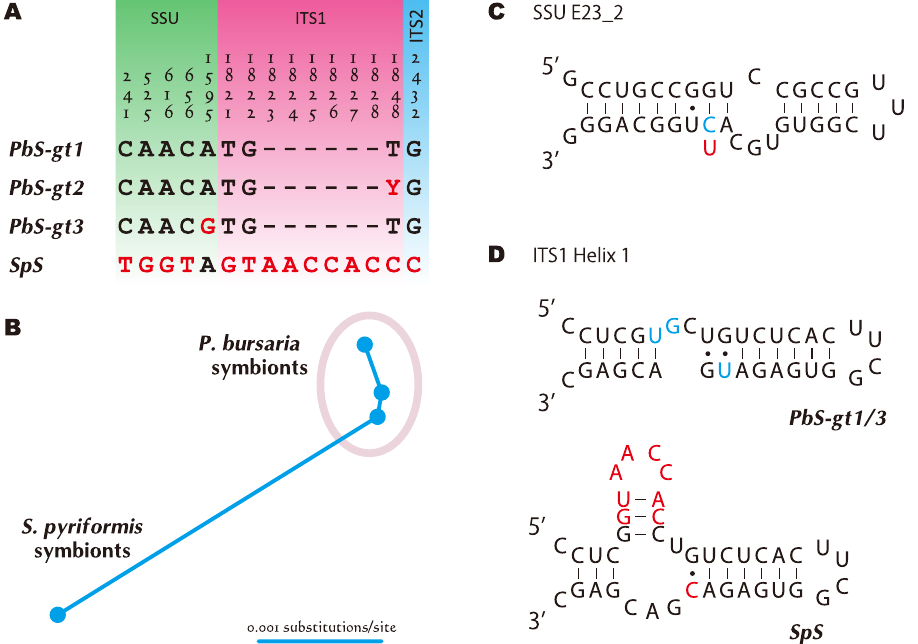
Figure 6. Sequence differences of SSU, ITS1, 5.8S and ITS2 rRNA gene (without group I introns) among Chlorella variabilis . “PbS-gt” indicates Paramecium bursaria symbiont genotypes. Genotype 1 includes SAG 211-6, ATCC 50258 (NC64A), NIES-2541, and some other US and Japanese strains. Genotype 2 is the alga of Chinese P. bursaria strain Cs2, and genotype 3 is the alga of Australian P. bursaria strain MRBG1. For further information, see Hoshina et al. 53 . “SpS” indicates the algal sequence of Stentor pyriformis strains collected from Japan. ( A ). Different positions. Numerals represent the nucleotide number in aligned sequences (2462 aligned sites). ( B ). Distance tree of above four types of sequences. ( C ). E23_2 helix of SSU rRNA structure that includes hemi-CBC at the alignment position 656. ( D ). Deformation of ITS1 Helix 1 associated with the mutations including several nucleotide